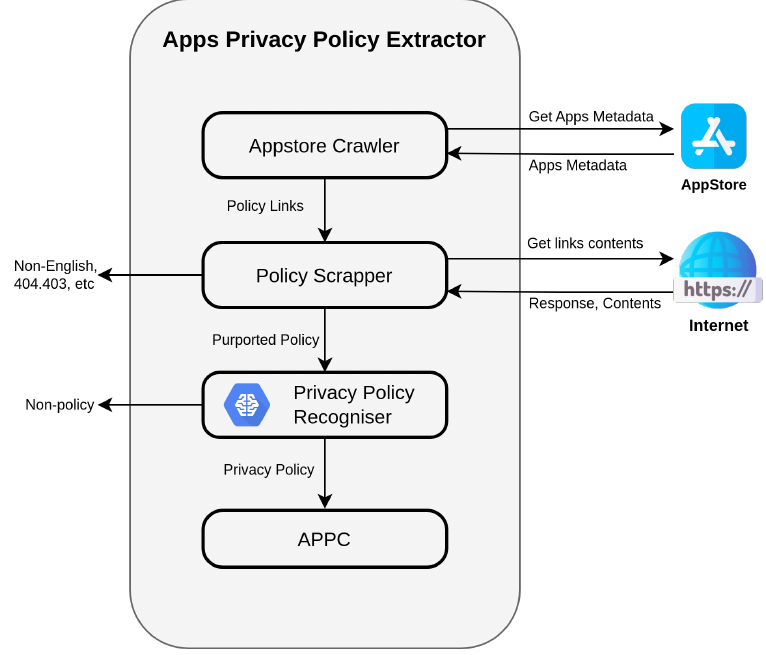
Figure 1. Overview of the App Privacy Policy